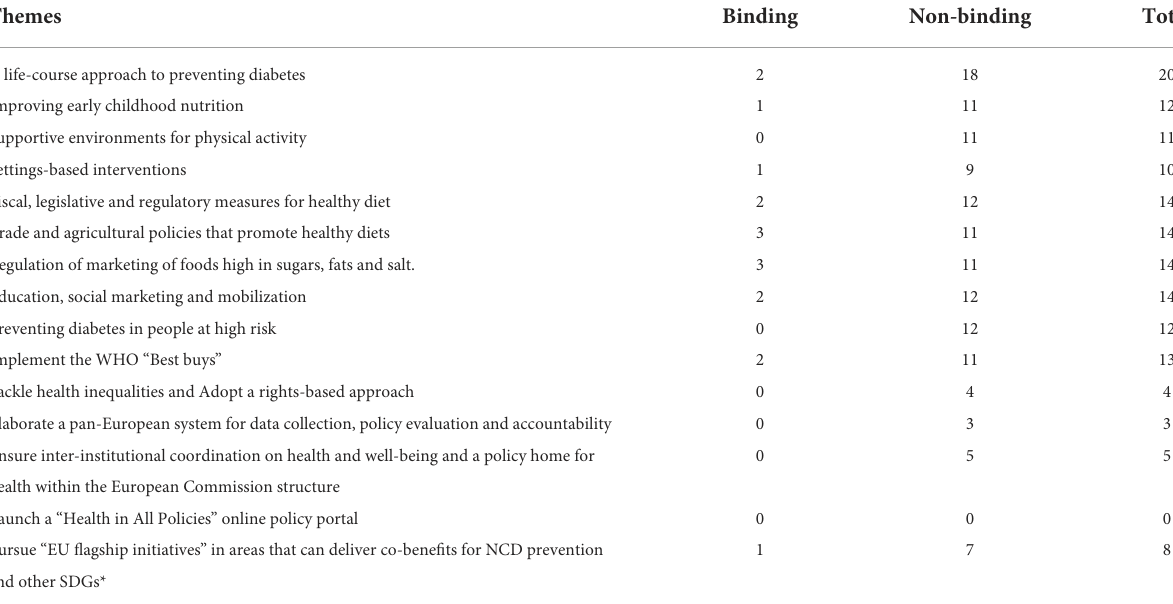
TABLE 1 Assessment of legislations according to the WHO Global report on diabetes and EU strategic framework for the prevention of NCDs guidelines.